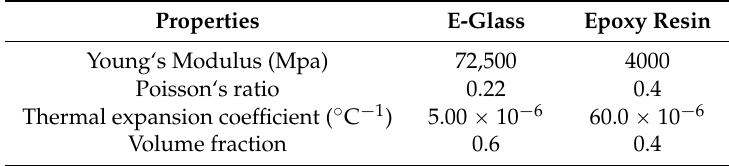
Table 1. A summary of relevant properties that were used for computing the thermal expansion of the unidirectional 16-ply E-glass/epoxy resin composite.